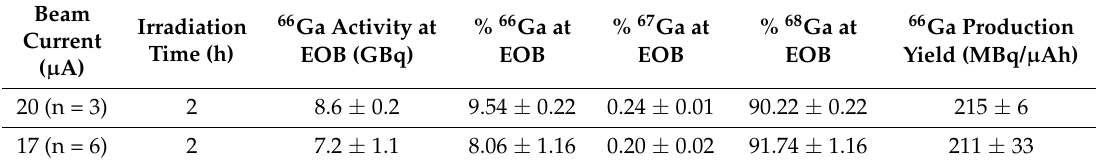
Table 1. Comparison of 66 Ga production following 15 MeV proton bombardment of a 100 µ m nat Zn foil